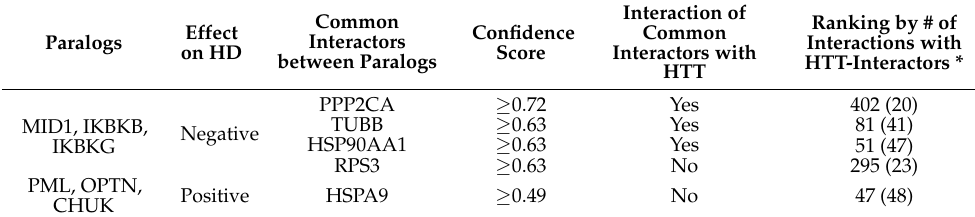
Table 2. Common interacting partners between negative and positive